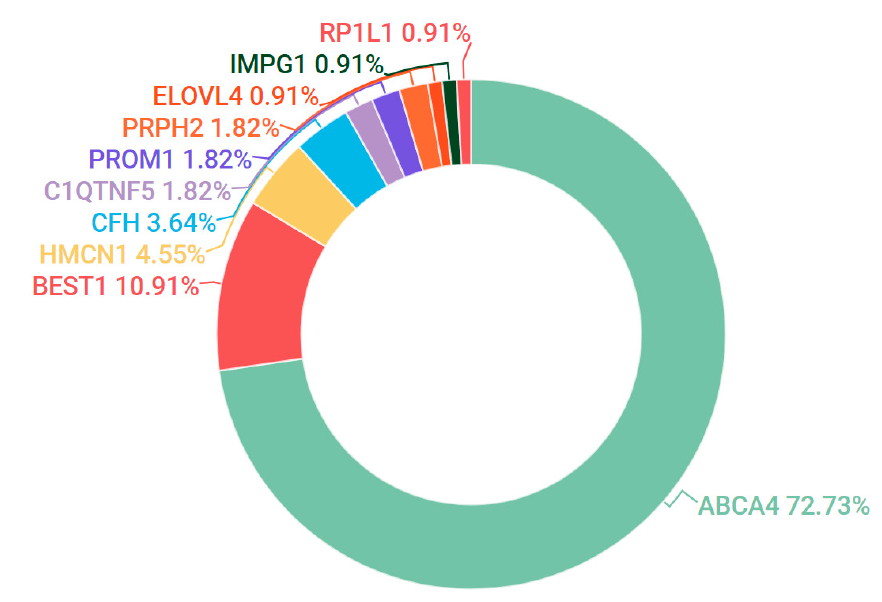
Figure 3. Gene candidates (and percentages) observed in the IRD grouping encompassing Stargardt disease, fundus flavimaculatus (FFM) and macular dystrophy (MD).